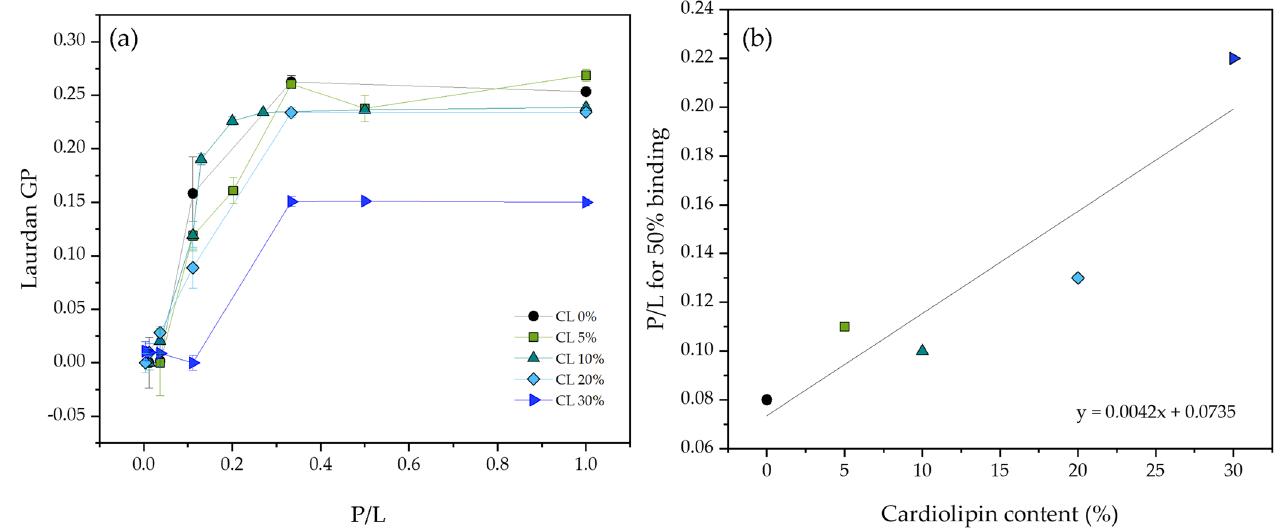
Figure 3. ( a ) ATRA − 1 binding isotherms in the presence of DMPG unilamellar vesicles containing varying amounts of CL, as measured by monitoring Laurdan generalized polarization. ( b ) P/L ratio needed to reach 50% binding is plotted as a function of cardiolipin content. All measurements were performed at 37 ◦ C.